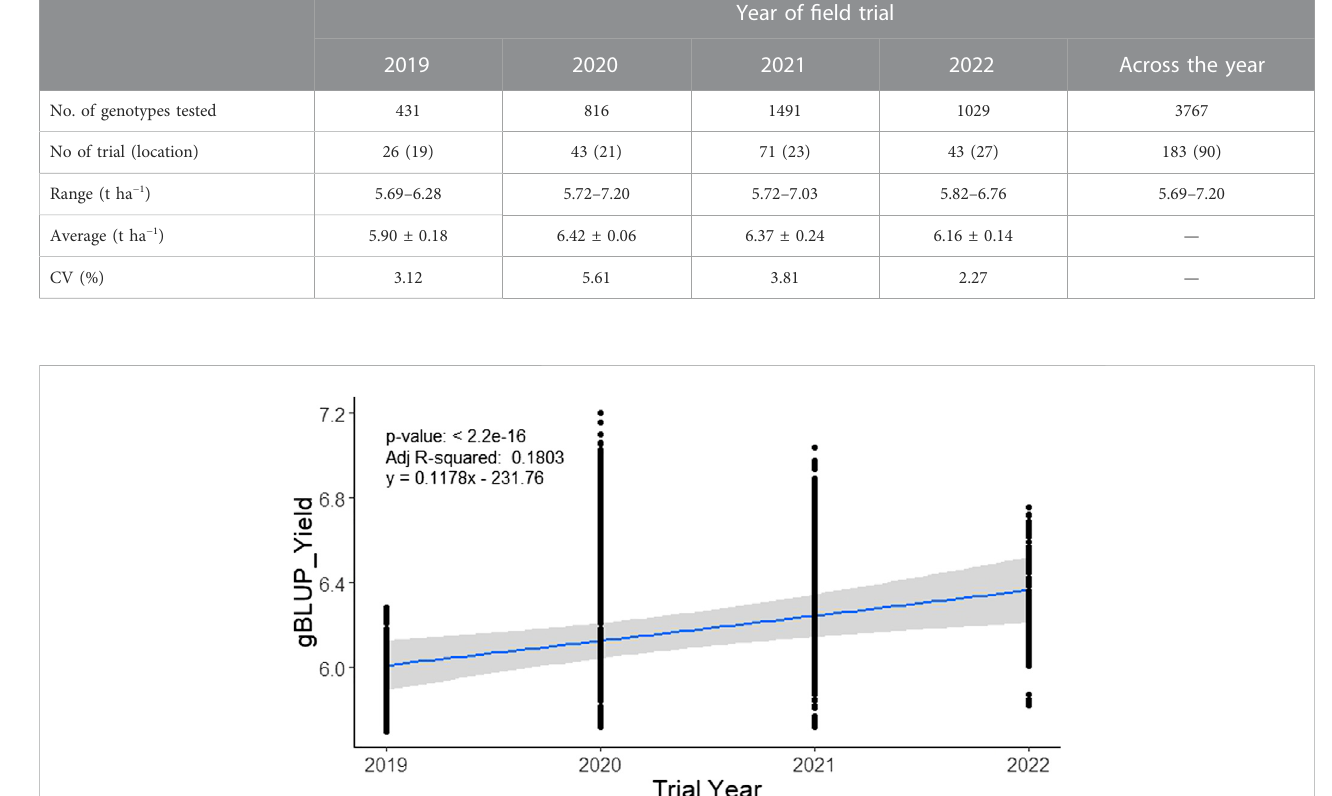
FIGURE 6 Genetic gain for yield in the irrigated breeding program of BRRI during 2019 – 2022. Genomic BLUP for the yield of each line was regressed over the year of the trial to obtain the rate of genetic improvement per